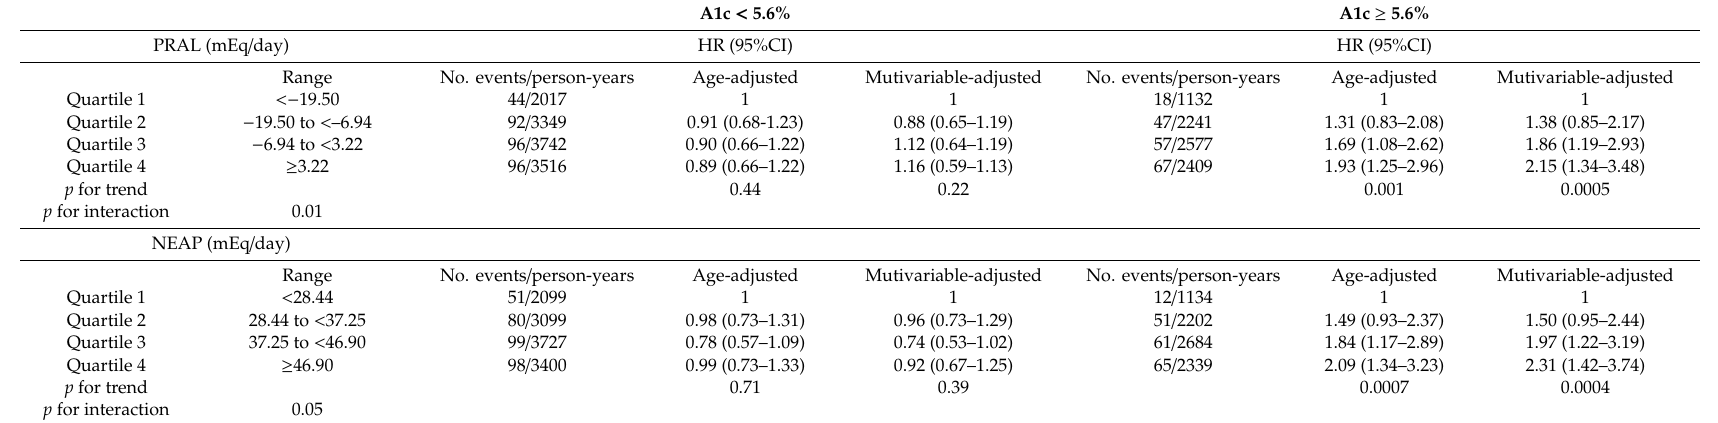
Table 5. Dietary acid load and risk of breast cancer recurrence, stratified by median levels of hemoglobin A1c in the WHEL